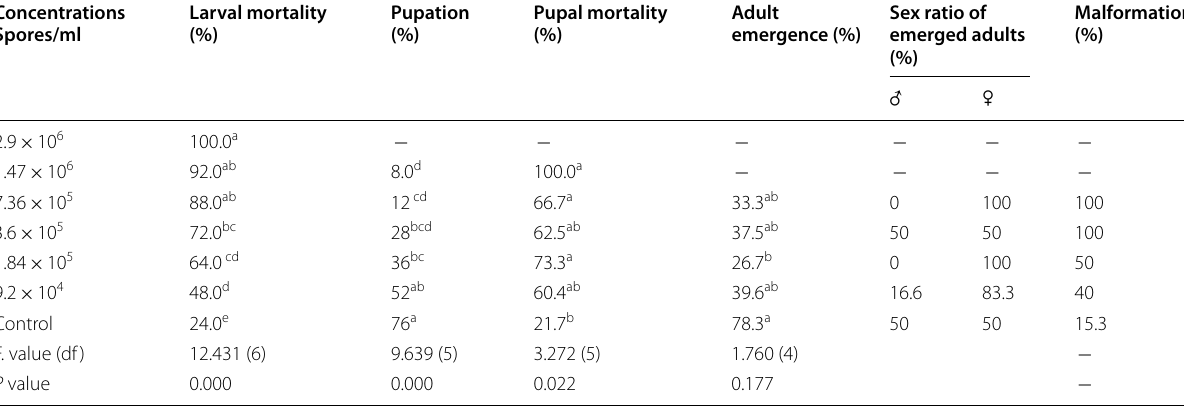
Table 4 Effect of isolated strain of Beauveria bassiana on Agrotis ipsilon last instar larvae